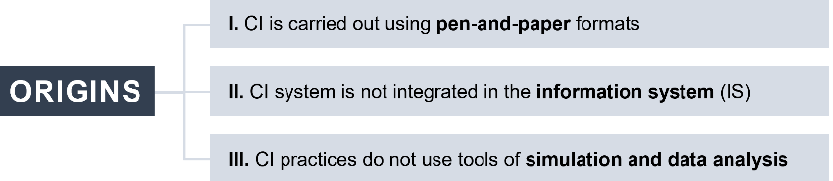
Figure 1. Typical origins of the challenges and limitations of conventional CI practices.